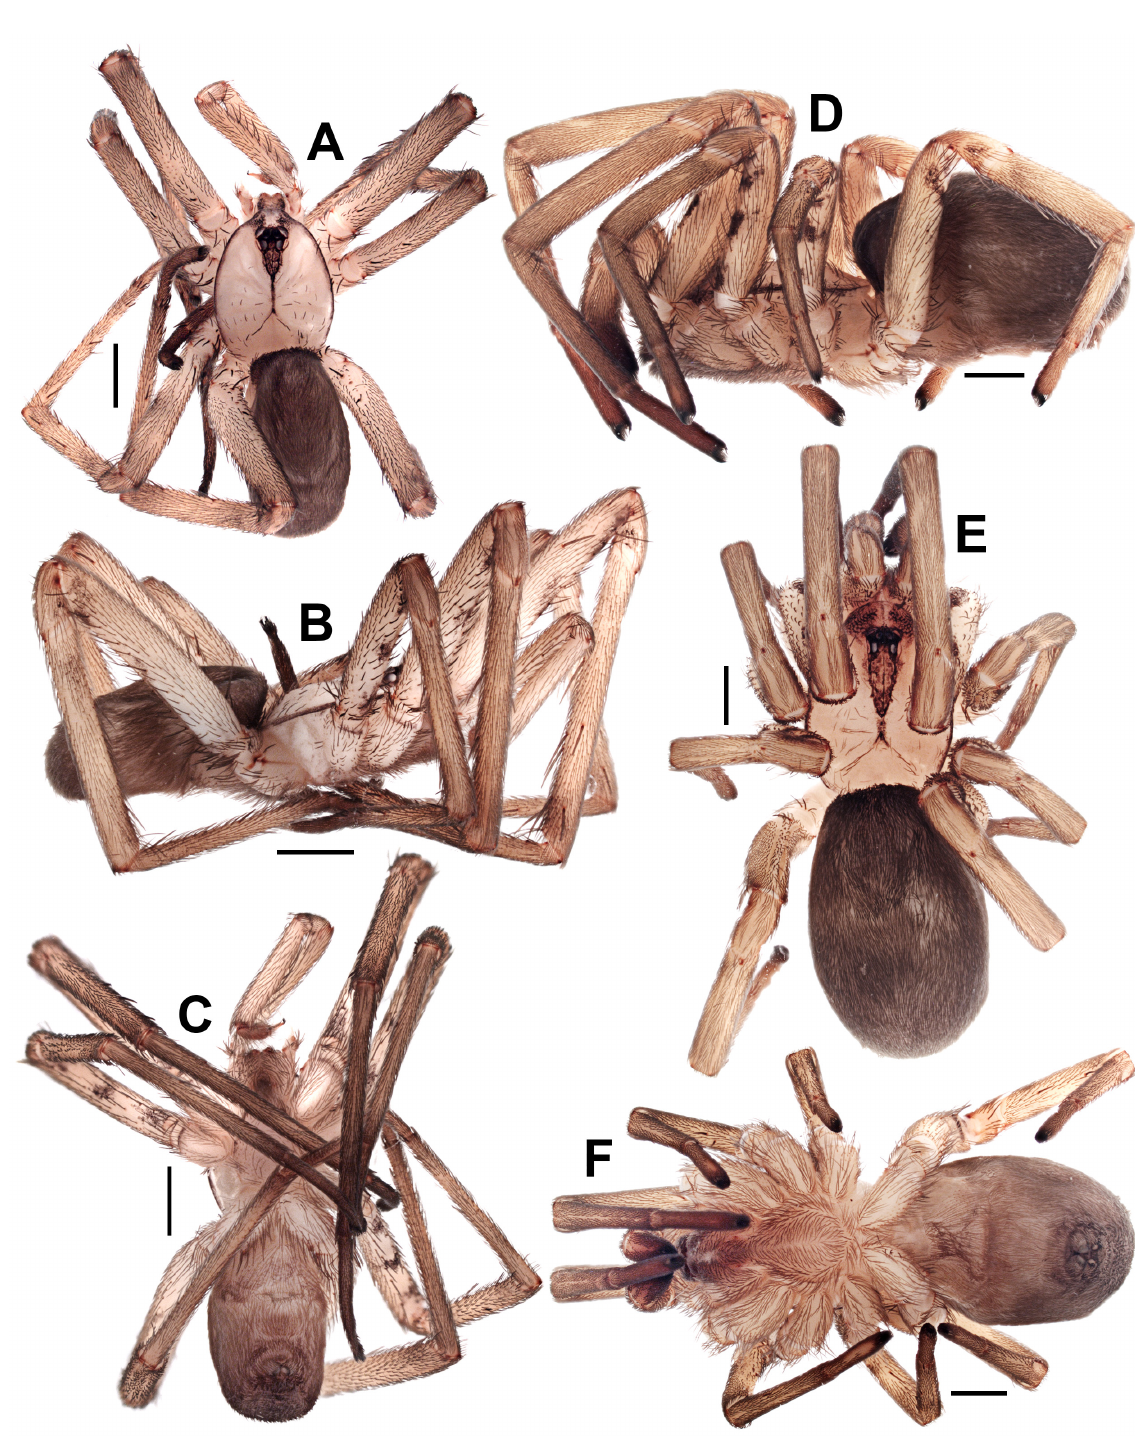
Fig. 7. Filistata betarif sp. nov., habitus. A–C . Holotype, ♂, from Tinshemet cave (HUJ -INVAr 21058). A . Dorsal view. B . Lateral view. C . Ventral view. — D–F . Paratype, ♀, from the same locality (MACN- Ar 41222). D . Lateral view. E . Dorsal view. F . Ventral view. Scale bars = 1